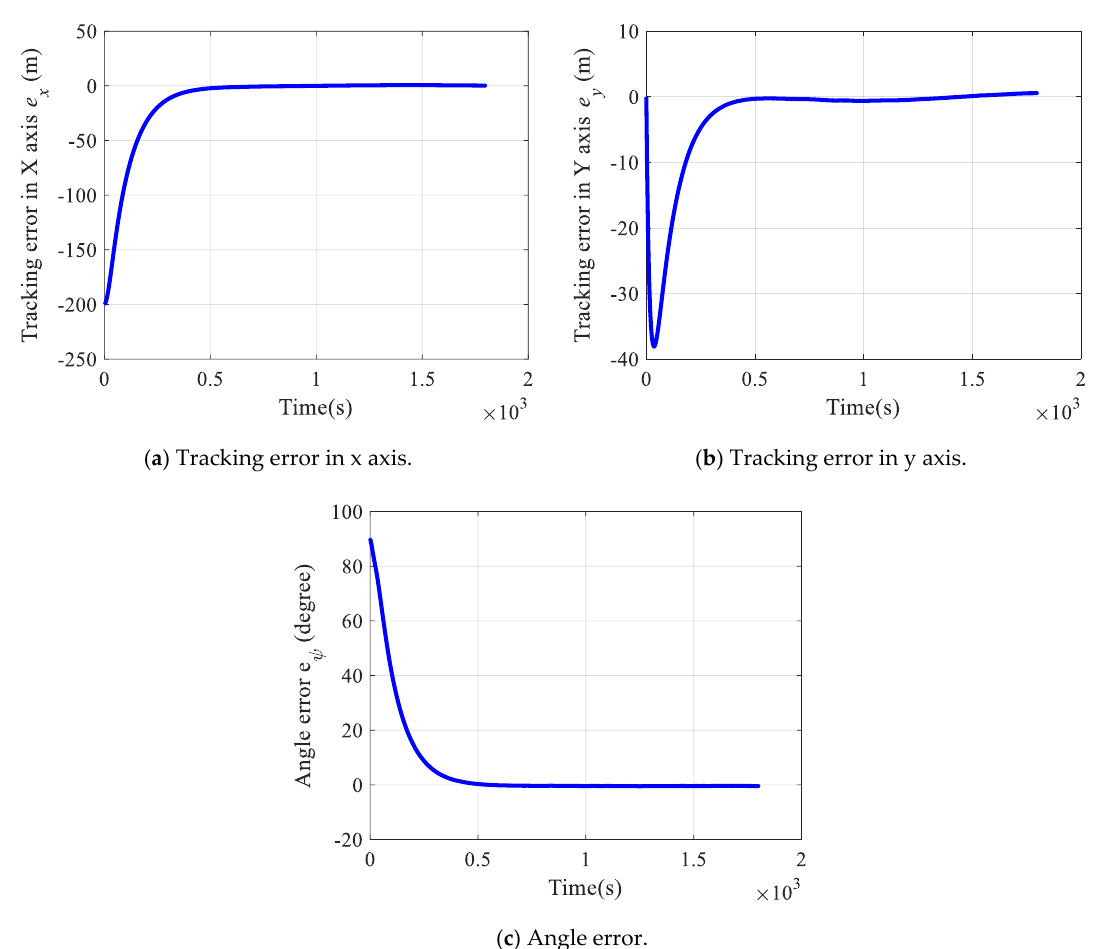
Figure 4. Tracking errors in x , y , and ψ of controlled AUSV: proposed method, blue solid line; desired trajectory, black dashed line.